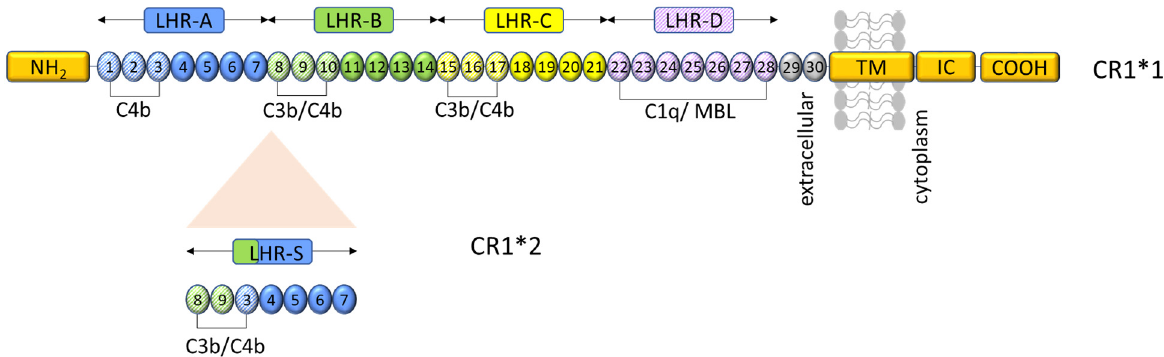
Figure 3. Representation of CR1 structure and ligand binding sites. CR1*1 comprises, from the amino terminus (NH 2 ), four long homologous repeats (LHRs A-D), each composed of seven short consensus repeats (SCRs) of 60–70 amino acids each, two additional SCRs, a transmembrane segment (TM), and an intracytoplasmic carboxy-terminal domain (IC-COOH). Each circular block represents an SCR (numbered 1–30). There are three C4b binding sites (SCR 1–3, 8–10, and 15–17) and two C3b binding sites (SCR 8–10 and 15–17). SCRs 22–28 bind C1q, MBL, and ficolins. CR1*2 has an additional LHR domain (LHR-S) inserted between LHRs A and B and consequently an extra C3b/C4b binding site. Schematic based on similar figures in the work of